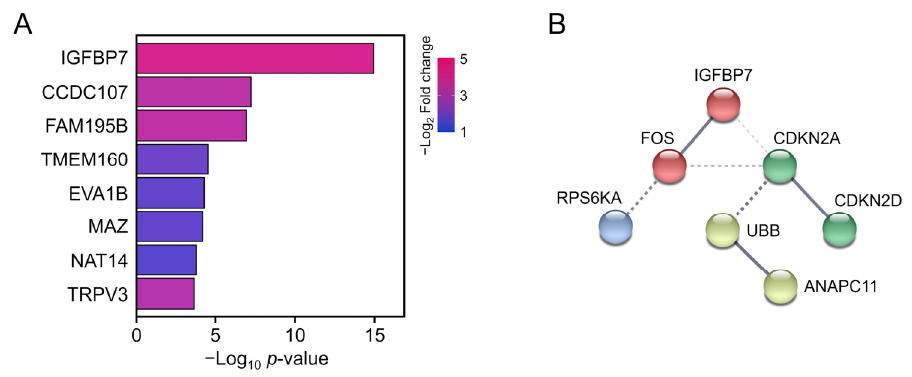
Figure 6. ( A ) Top eight annotated differentially expressed genes. Bar color represents the log 2 fold- change value. Bar length represents the p -value. ( B ) Schematic of protein–protein interactions. Solid lines represent proven relationships. Dotted lines indicate putative associations.